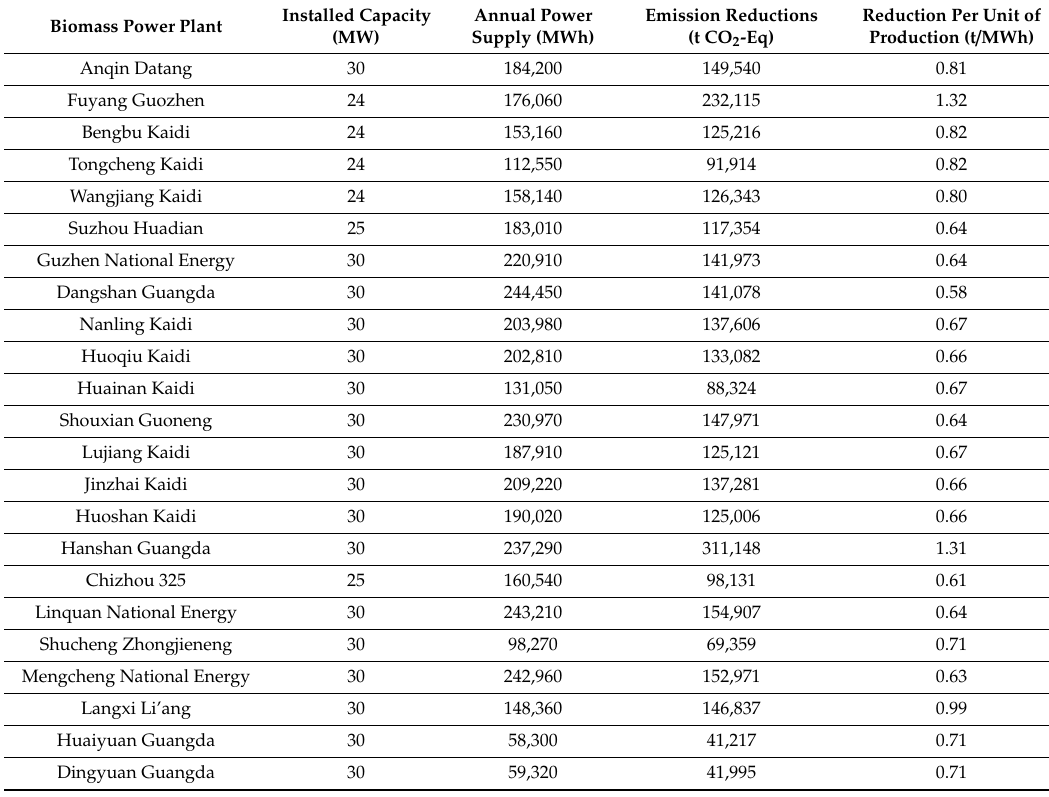
Table 1. Emission reductions of biomass power plants in